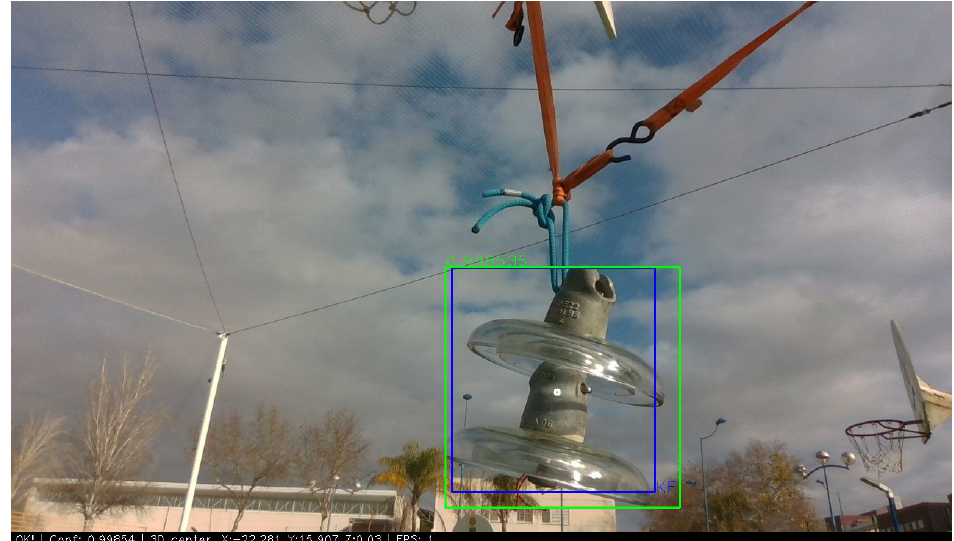
Figure 7. Insulator detection using YOLO v4 Tiny with TensorRT implementation (green bounding box) and tracker result (blue bounding